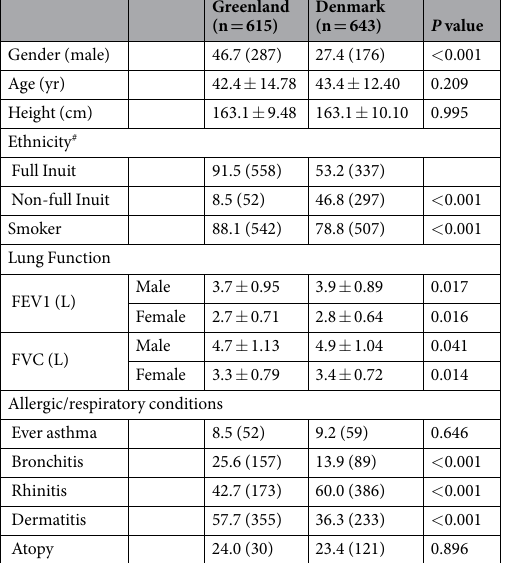
Supplementary Table S2. After adjusting for gender, age, height, ethnicity and smoking status, ORMDL3 SNPs (rs12603332 and rs4065275) were significantly associated with lung function (FEV1 and FVC) in Greenlandic